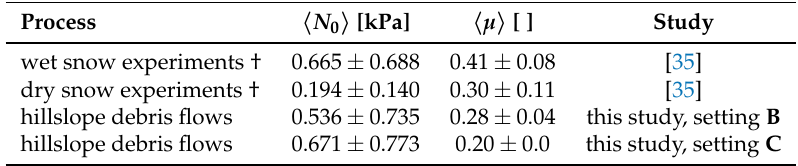
Table 5. Comparison of averaged yield stress values of the flow N 0 and dry Coulomb friction parameters µ for dense snow avalanches based on snow chute experiments and back-calculated values of setting B and C for this